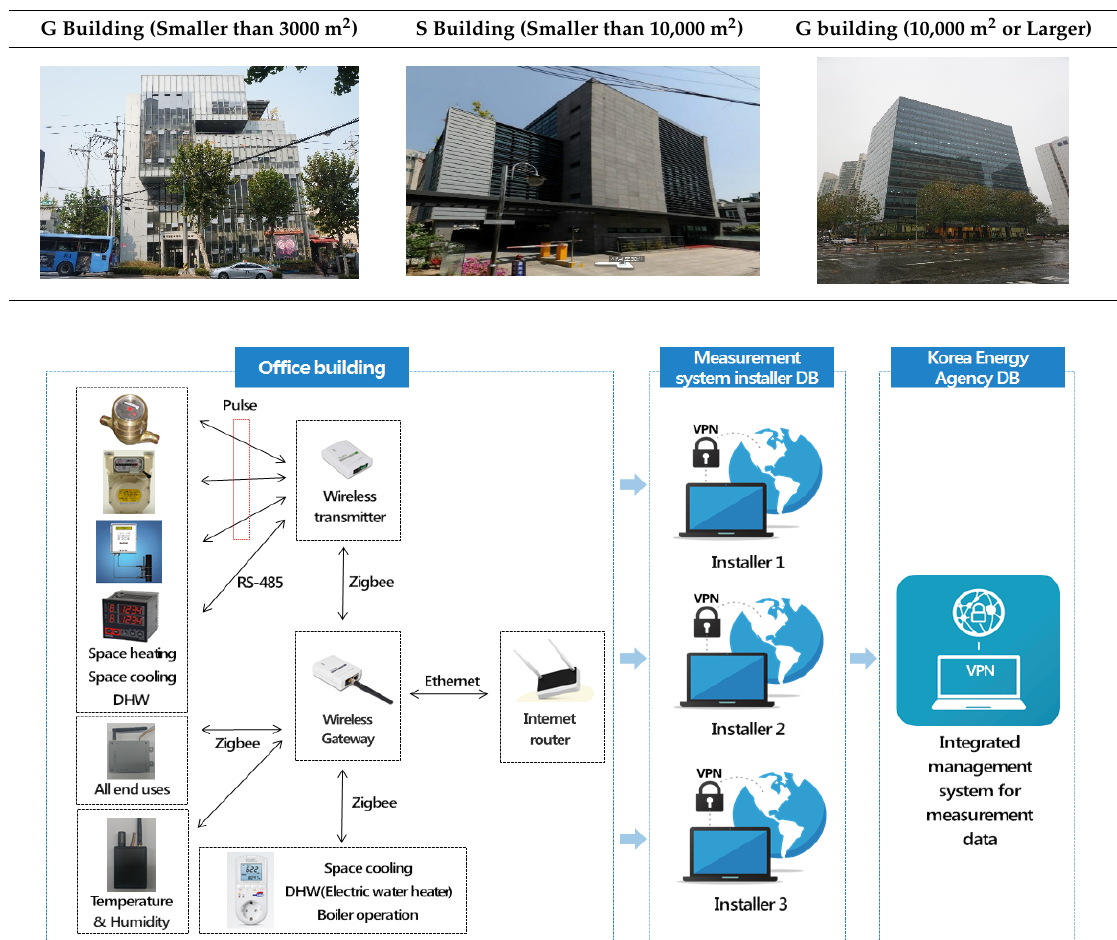
Figure 1. Measurement data collection system. Table 4. Photographs of sample office buildings .